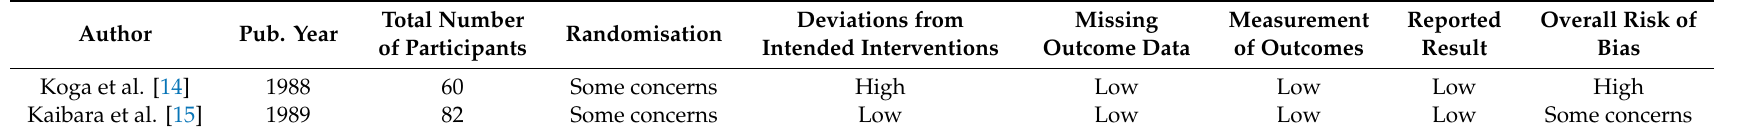
Table 1. Risk of bias of randomised controlled trials.